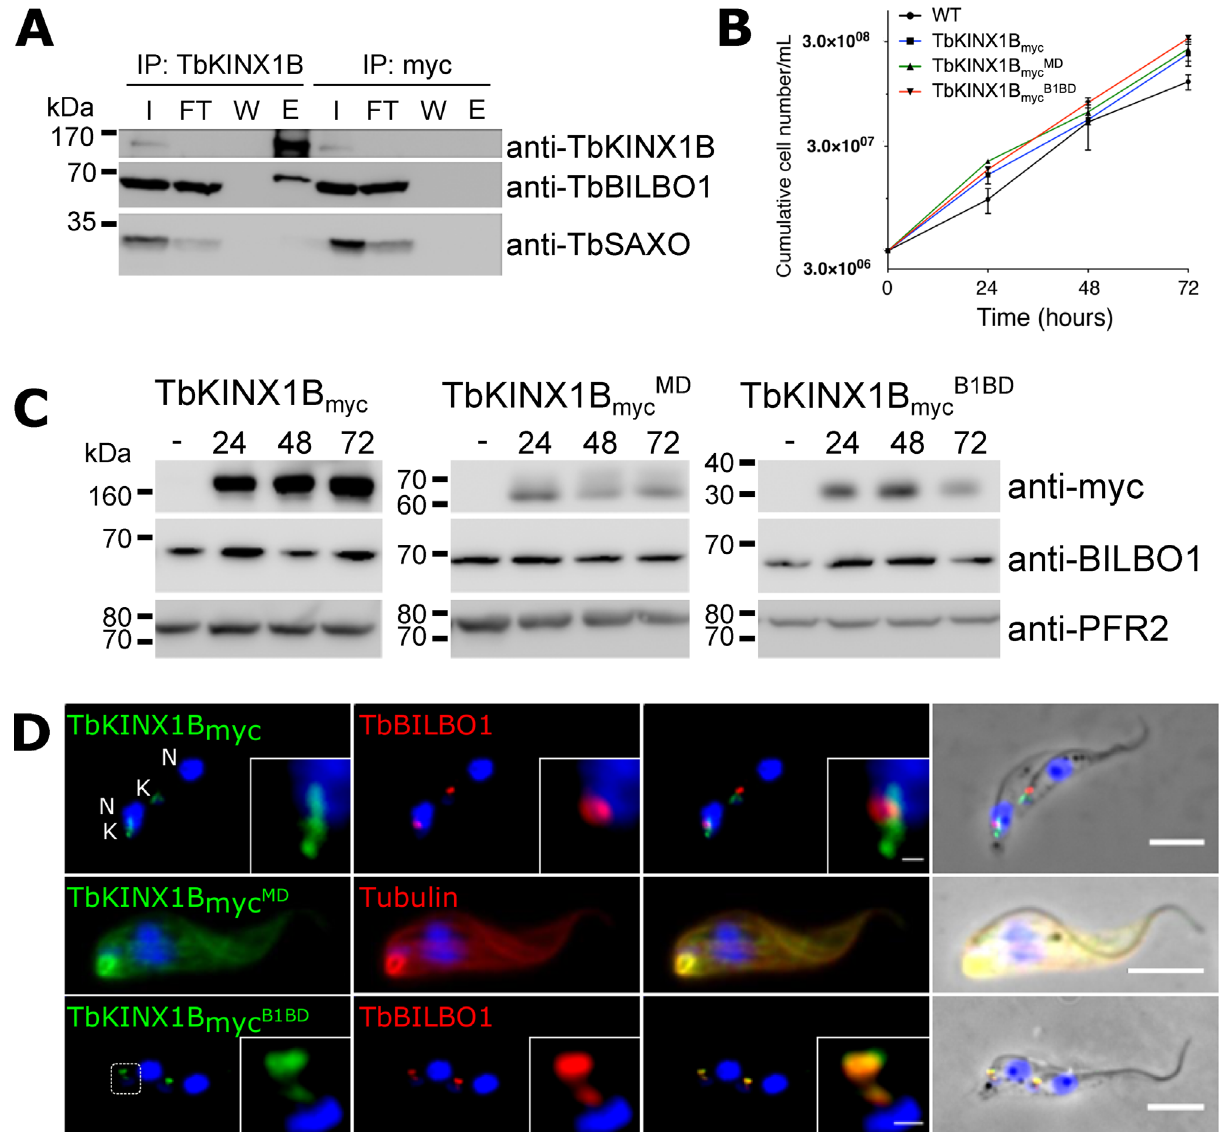
Figure 3. Microtubule and FPC localization of TbKINX1B depends on its motor domain and BILBO1-binding domain respectively . A. Immuno-precipitation of TbKINX1B and immuno-detection by western blotting of TbKINX1B and TbBILBO1 on input (I), fl ow-through (FT), wash (W), and elution (E) fractions. B. Induction of the expression of TbKINX1B myc , TbKINX 1 B mycMD or TbKINX 1 B mycB 1 BD does not affect PCF cell growth, as compared to WT ( n = 3). C. Western blot of PCF WT cells and cells non-induced ( – ) or tetracycline-induced 24 h, 48 h, 72 h for the expression of TbKINX1B myc (151 KDa), TbKINX 1 B mycMD (62 KDa) or TbKINX 1 B mycB 1 BD (28 KDa). Expressed proteins were detected using anti-myc antibody and using PFR2 (L8C4) as a loading control. No alteration on TbBILBO1 protein levels was observed. D. Co-immunolabelling on detergent-extracted cells of TbKINX1B myc and TbKINX 1 B mycB 1 BD proteins (green) with TbBILBO1 (red), and of TbKINX 1 B mycMD (green) with Tubulin